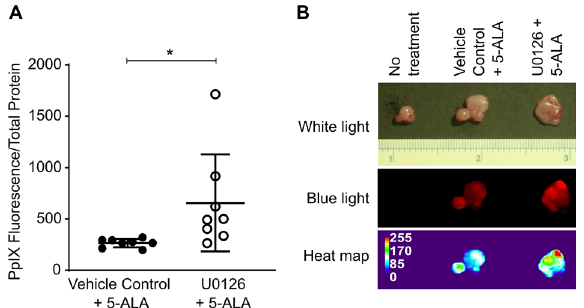
Figure 3. MEK inhibition enhanced tumour PpIX fluorescence in spontaneous tumours developed in HRAS transgenic mice. HRAS mice with palpable salivary gland tumours were treated i.v. with U0126 or control vehicle for 5 h and then i.p. with 5-ALA for 2 h. ( A ) PpIX fluorescence in tumour homogenates normalised to total protein between mice treated with vehicle control + ALA and mice treated with U0126 + ALA is shown (n = 8/group). *p < 0.05 by Student’s t -test. ( B ) Representative image of tumours in HRAS transgenic mice left untreated or treated with vehicle control + 5-ALA, or U0126 + 5-ALA and heat map generated based on tumour